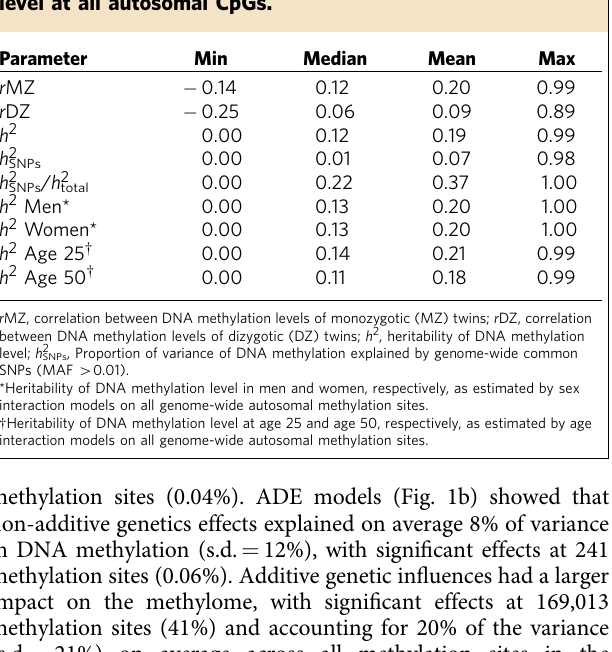
Table 2 | Twin correlations, heritability and variance explained by common genetic variants for DNA methylation level at all autosomal